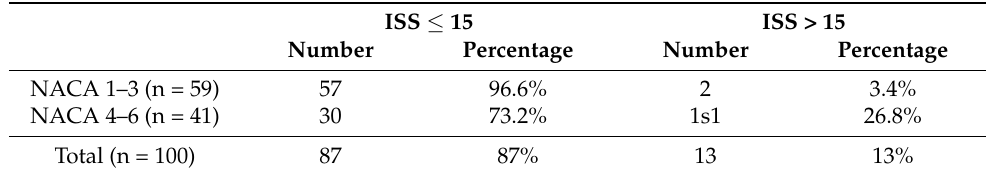
Table 2. Under- and